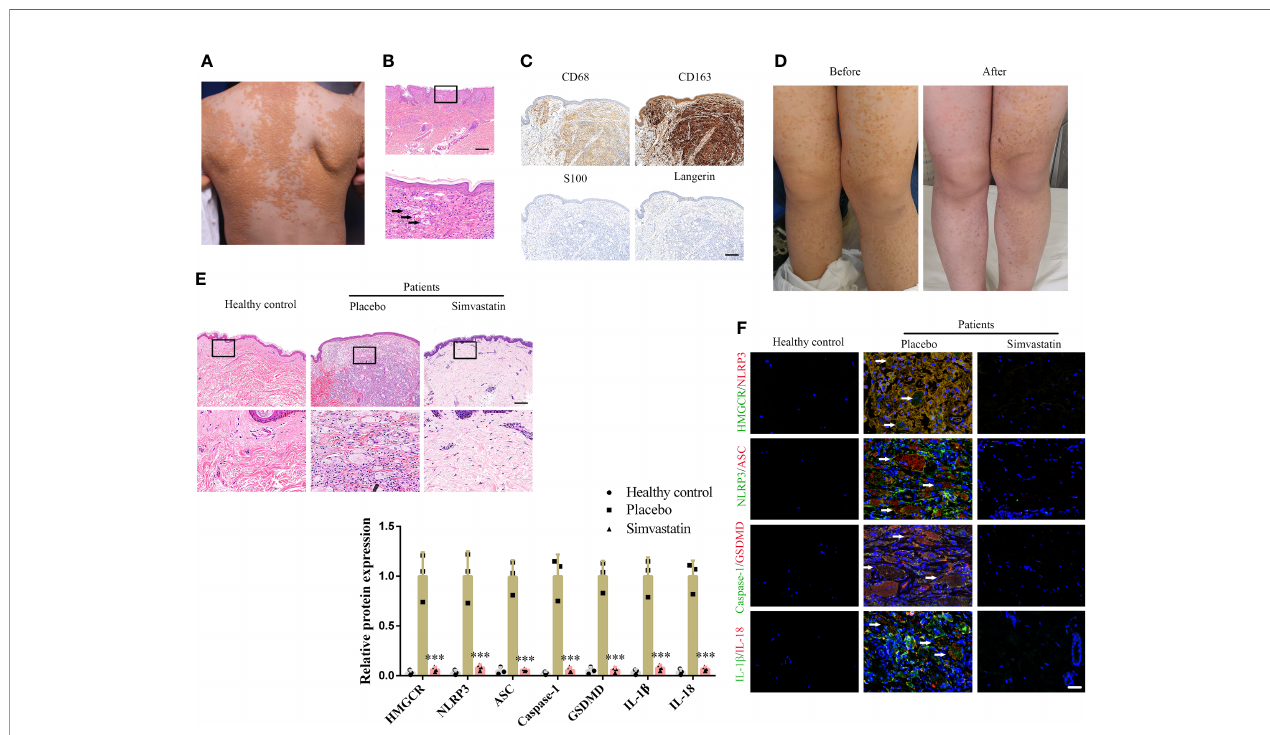
FIGURE 1 | Simvastatin improves clinical manifestations and inhibits pyroptosis in the dermis. (A) Patient ’ s clinical symptoms. (B) Hematoxylin & eosin (H&E) staining showing foam cells (black arrow) and Touton giant cells (white arrow). Scale bar, 200 m m. (C) Immunohistochemical staining for diagnosis. Scale bar, 100 m m. (D) Patient ’ s clinical symptoms before and after simvastatin treatment. (E) H&E staining showing foam cells and in fl ammatory cells treated with placebo (left side of body) and simvastatin (right side of body). Scale bar, 100 m m. (F) Immuno fl uorescence staining to detect HMGCR, NLRP3, ASC, caspase-1, GSDMD, IL-1, and IL-18 levels in lesions treated with the placebo (left side of body) and simvastatin (right side of body). Arrow (foam cells). Scale bar, 25 m m. ***p < 0.001, versus the